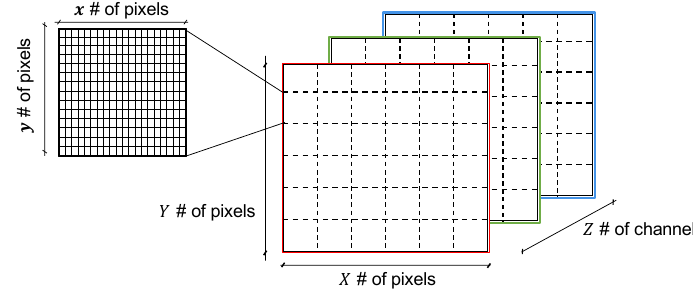
Figure 3. Image and